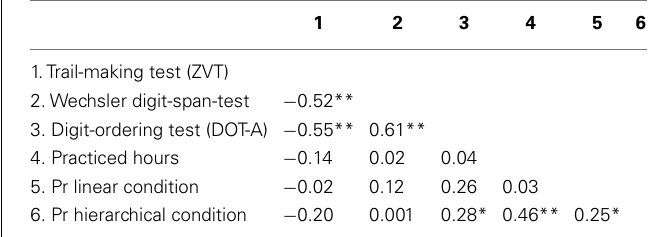
Table 1 | Correlation between the measures of the cognitive test battery and the performance in the linear and hierarchical syntax condition.